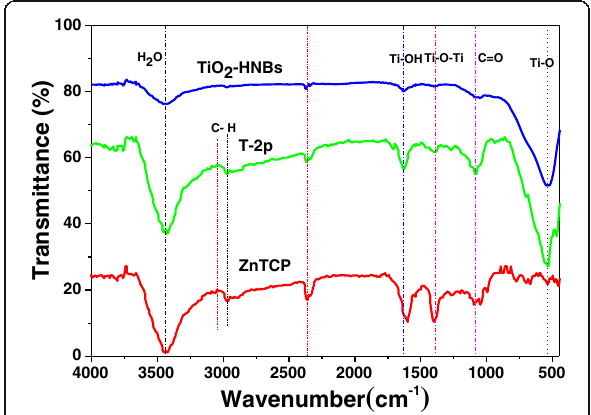
Fig. 6 FT-IR spectra of TiO 2 -HNBs, ZnTCP, and T-2p